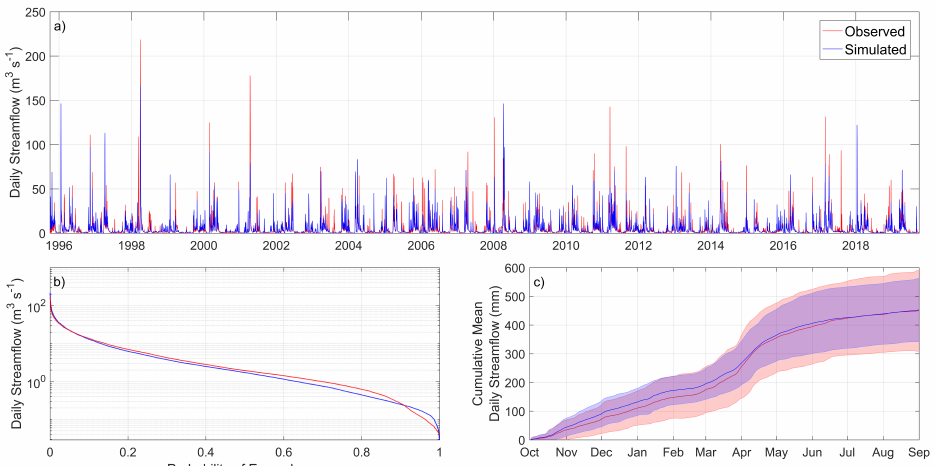
Figure 6. Assessment of the CRHM platform performance in simulating streamflow at the outlet of the Acadie River Catchment by comparing ( a ) daily streamflow, ( b ) flow duration curve, and ( c ) cumulative mean daily streamflow. The shades around the average values in panel ( c ) represent the inter-annual